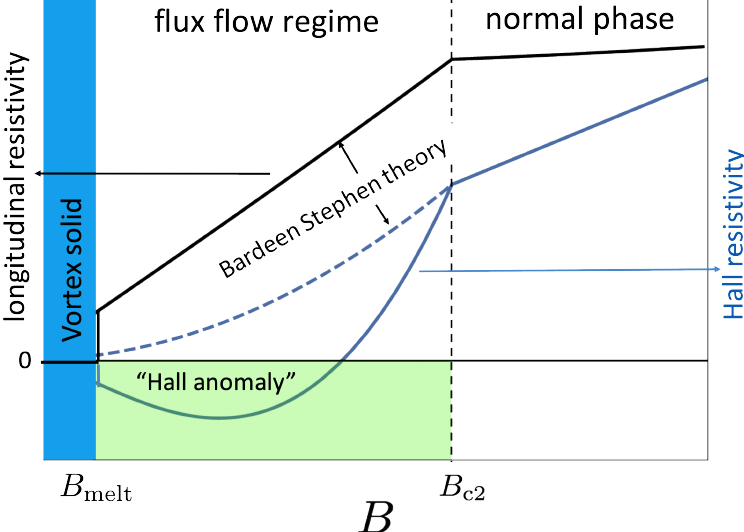
Figure 1: Bardeen Stephen theory and Hall anomaly in the flux flow regime. For this illustration, vortex cores are assumed to obey Drude theory of metals. The deviation of Hall resistivity from Bardeen Stephen theory, and its sign reversal, are ascribed to moving vortex